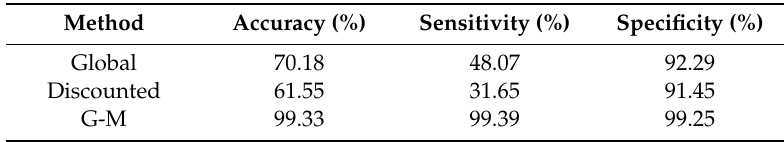
Table 4. Performance metrics of selected features versus global and discounted